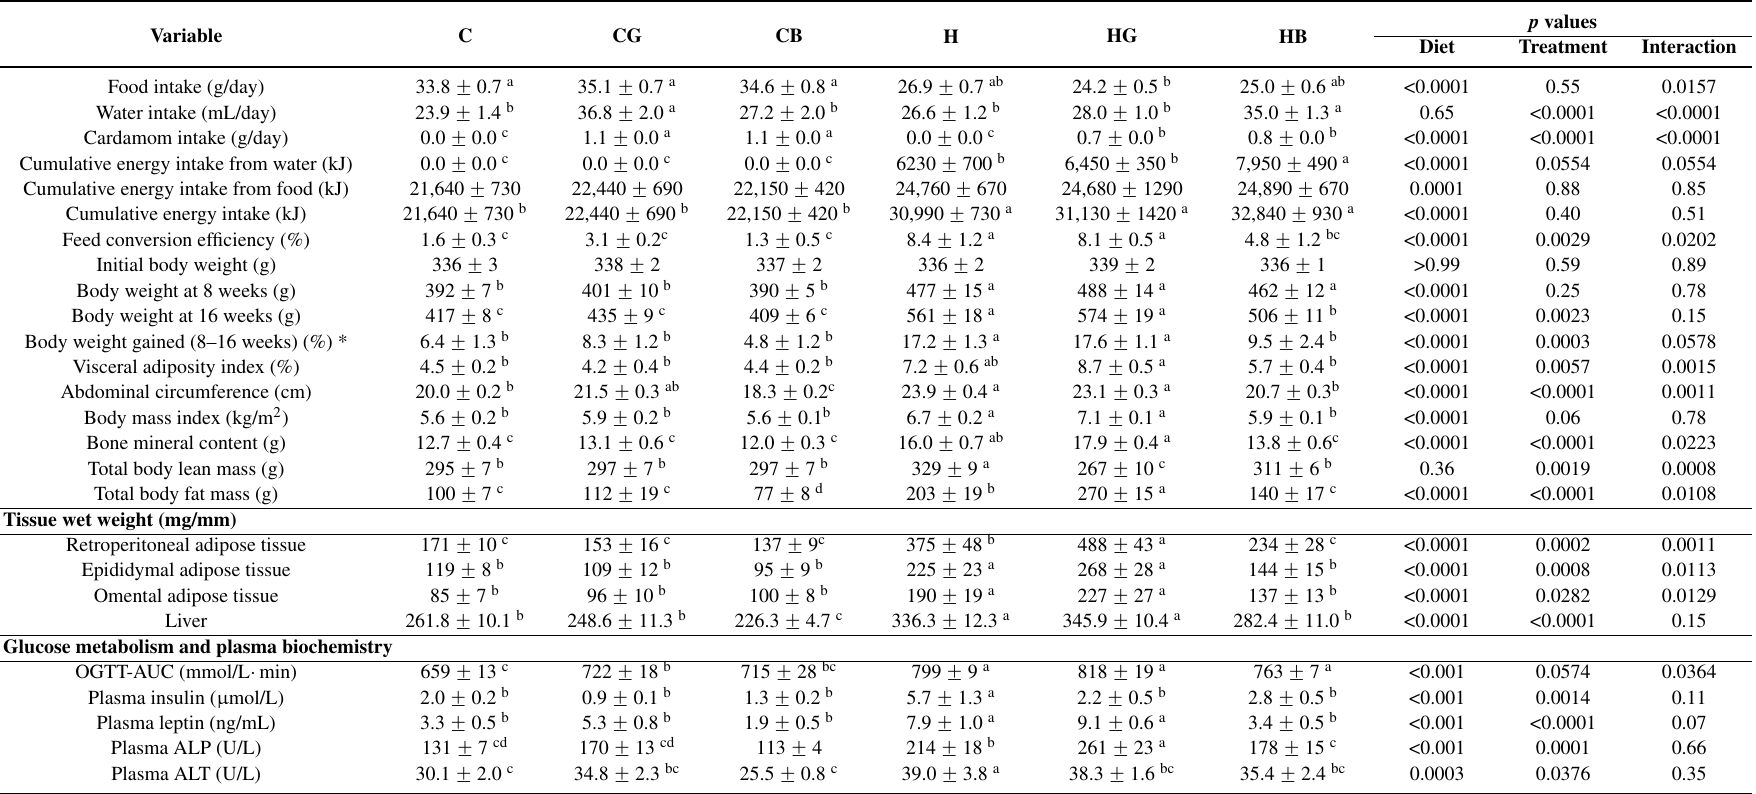
Table 3. Dietary intakes, body composition and anthropometrics, organ wet weights, changes in glucose tolerance test, plasma insulin and plasma biochemistry in corn starch (C), C + green cardamom (CG), C + black cardamom (CB), high-carbohydrate, high-fat (H), H + green cardamom (HG) and H + black cardamom (HB) diet-fed rats ( n = 8